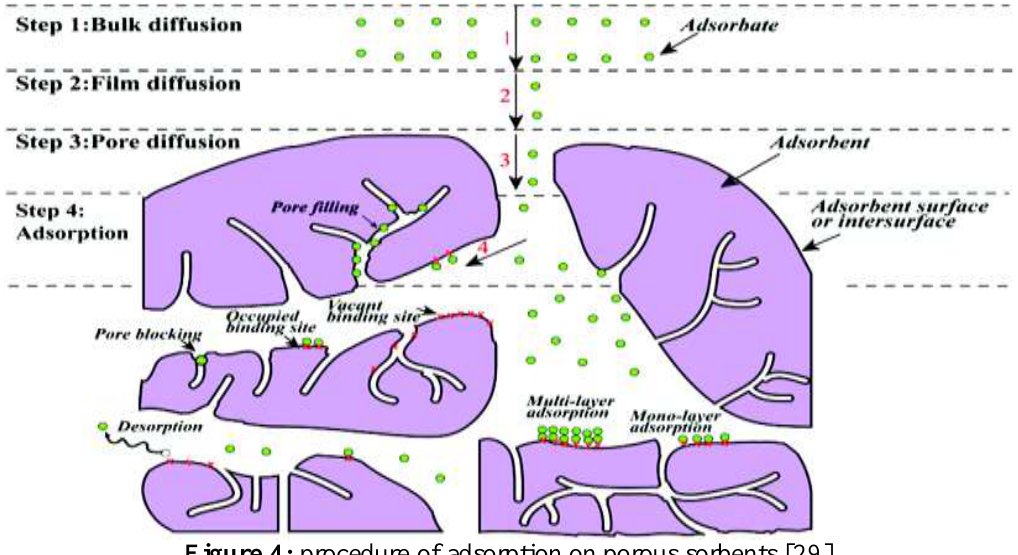
Figure 4: procedure of adsorption on porous sorbents